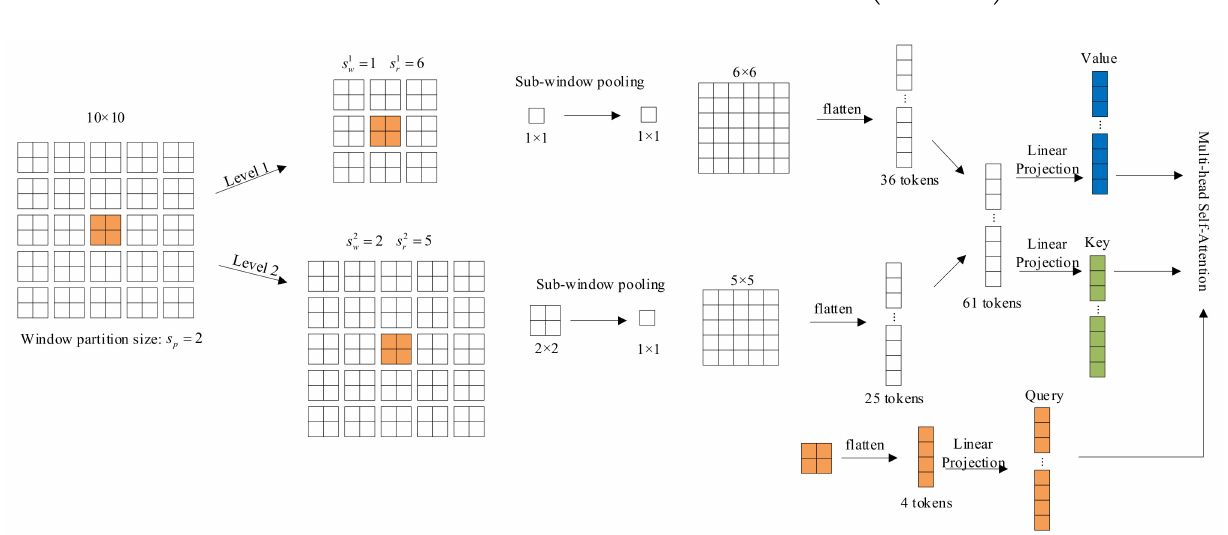
Figure 4. An illustration of focal self-attention mechanism. Each square in the figure is a visual token from the input feature map. Assuming the input feature map is of size 10 × 10, partition it into 5 × 5 windows of size 2 × 2. The 2 × 2 orange square in the middle is selected as a query, and its surroundings tokens at multiple granularities are extracted as its keys and values. For the first level, a 6 × 6 grid around the query is extracted as fine-grained tokens. For the second level, focus on the region of the entire feature map to obtain coarse-grained tokens, at which point 2 × 2 tokens are pooled into 1 × 1 tokens. Then the tokens of two levels are concatenated, and the keys and values corresponding to the query can be obtained through linear